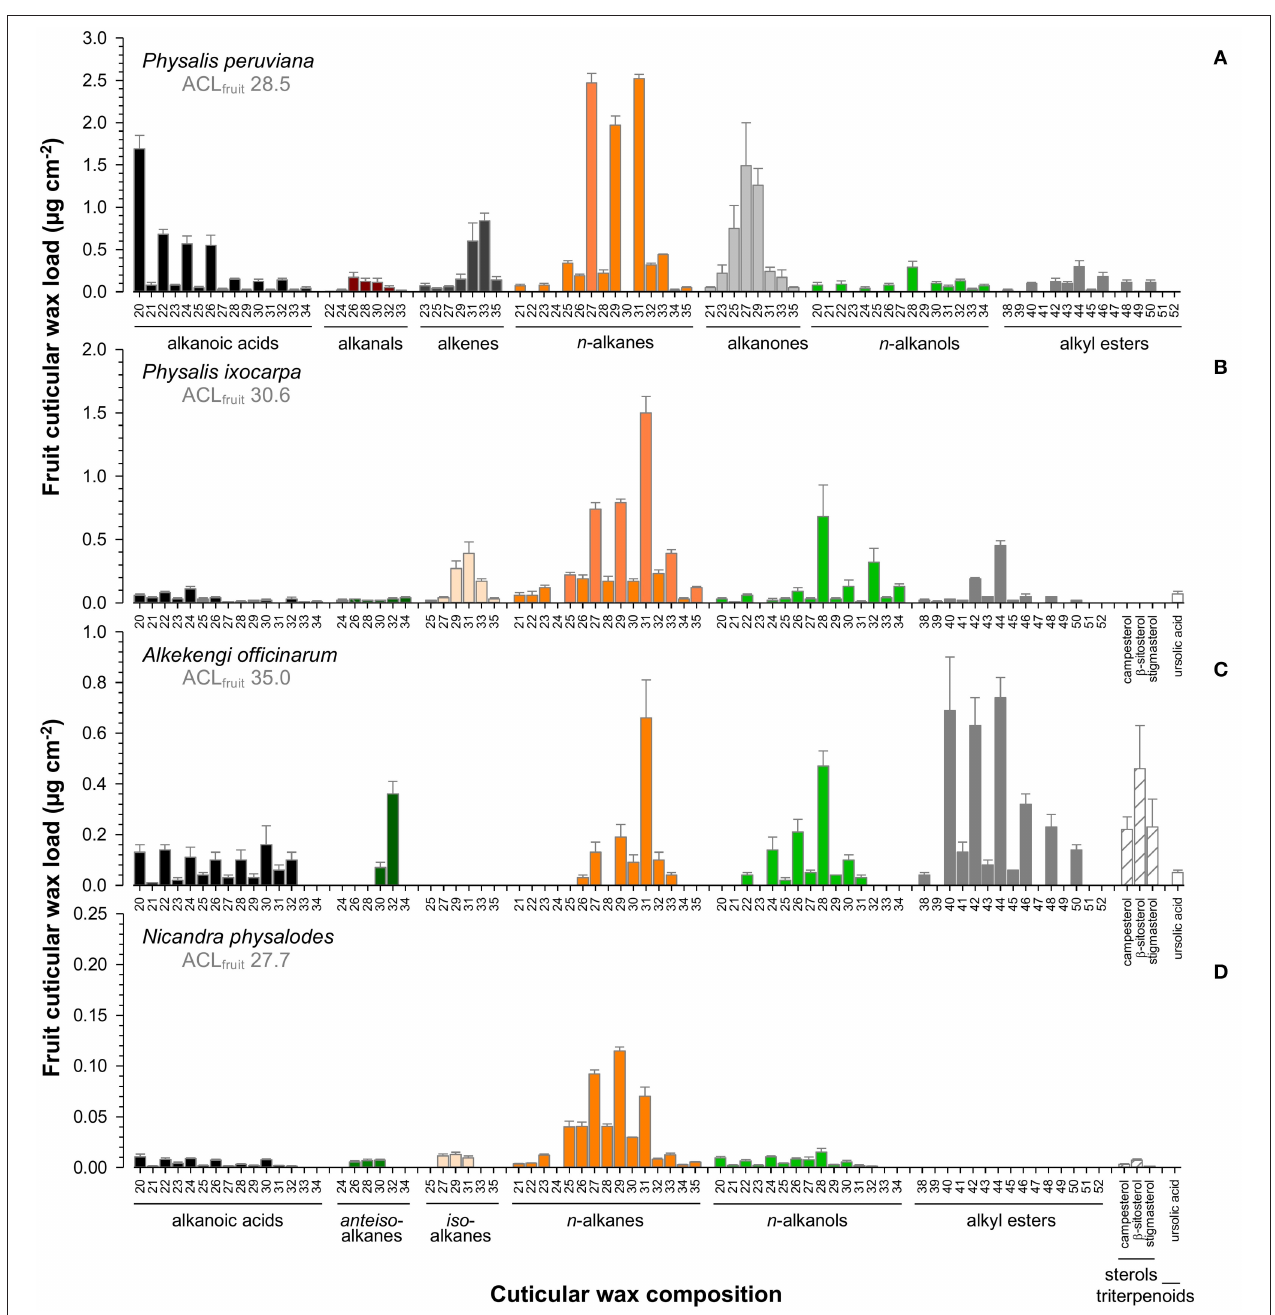
FIGURE 5 | Gas chromatographic analysis of the cuticular wax composition of Physalis ixocarpa (A) , Physalis peruviana (B) , Alkekengi officinarum (C) , and Nicandra physalodes (D) ripe fruits. Average carbon chain lengths calculated for the aliphatic wax fraction are given (ACL). Data are shown as mean ± SD ( n ≥